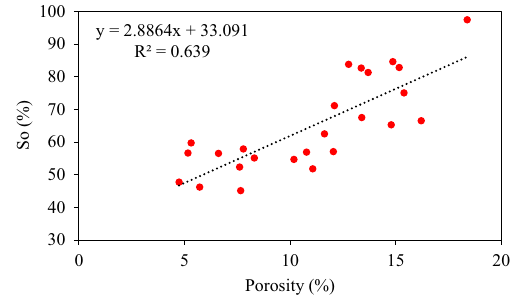
Fig. 7 Relationship between the reservoir oil saturation and porosity of the Lucaogou Formation in W174